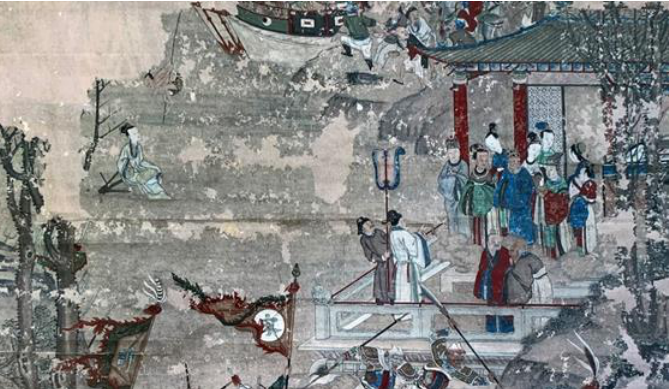
Figure 6. The image of Mazu in the “ One Family Honors ” , one of the stories in the third picture of “ Queen of Heaven Glorious Deeds Scroll ” . Source: author ’ s photograph.